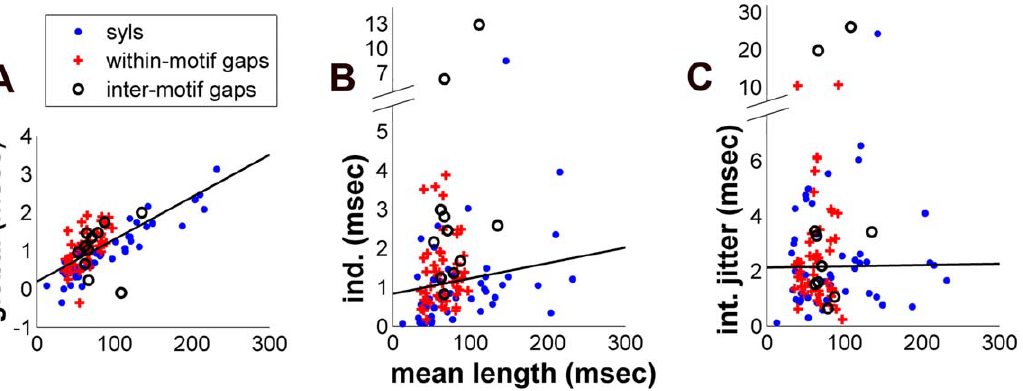
Figure 3. Scaling of timing parameters with average length. A, Scatter plot of global tempo variability by average interval duration across all syllables and silent gaps. Silent gaps within motifs and between motifs have been separated out. B, C, Analogous plots for the independent and jitter parameters respectively. In each plot solid lines come from a regression of timing parameters on average interval duration, calculated across birds. Overall, plots show that global and independent variability scale with average duration, while jitter does not. The plots also show systematic differences among interval types with respect to how much each parameter scales with average duration.